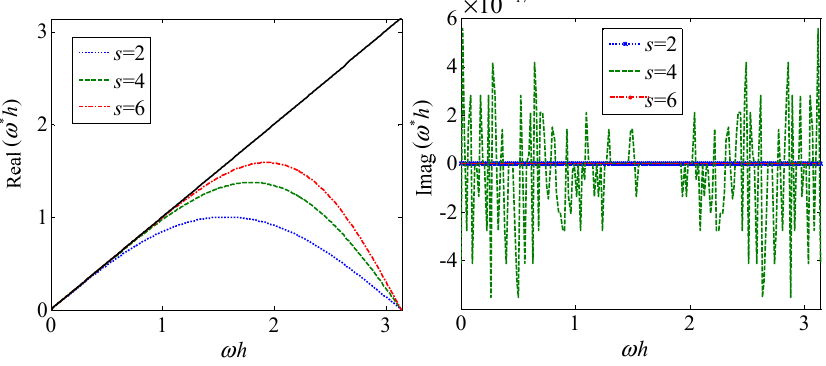
Figure 4. Plot of real and imaginary parts of the modified wavenumber for central compact difference schemes (CCDS).